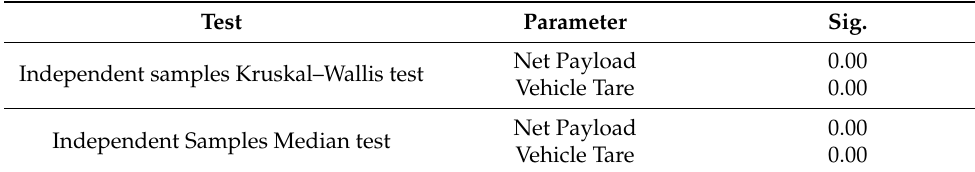
Table 5. Kurskal–Wallis test results.